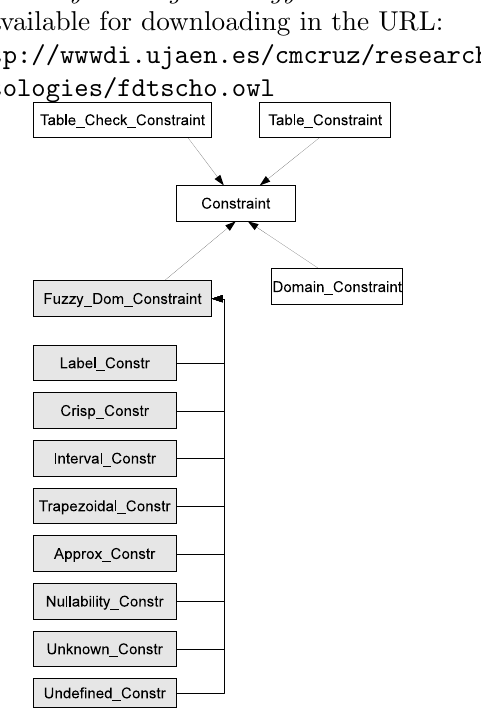
Fig. 2. Fuzzy Catalog Ontology Constraints. struc- tures.